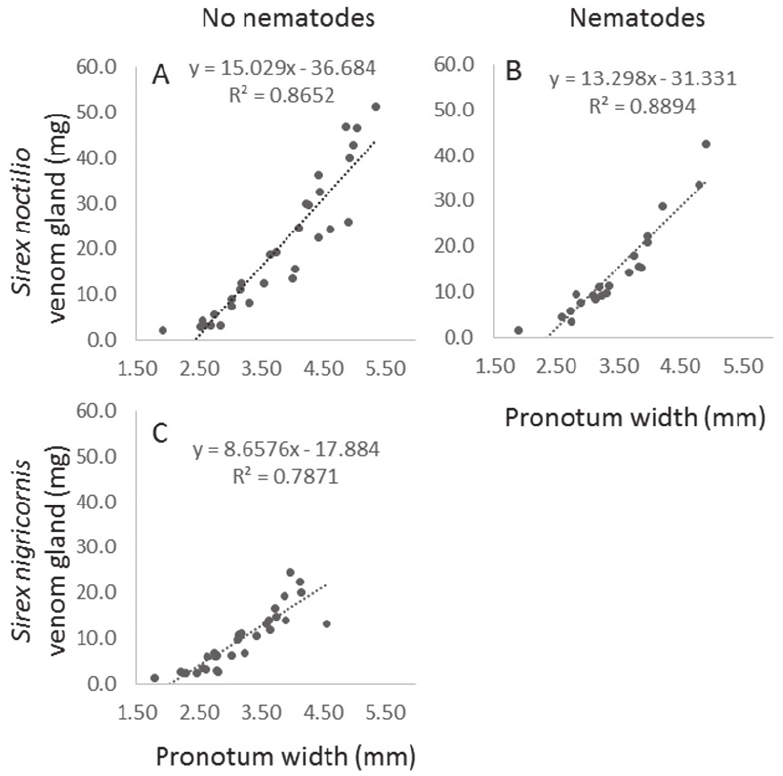
Figure 1. Relationships between venom gland mass and body size, measured as pronotum width, for S. noctilio and S. nigricornis . Sirex noctilio data were analyzed by presence or absence of parasitism by nematodes ( Deladenus siricidicola ) while numbers of S. nigricornis parasitized by nematodes were too low for analysis. A Sirex noctilio females without parasitism by nematodes B S. noctilio females parasitized by nematodes, and C S. nigricornis without nematode